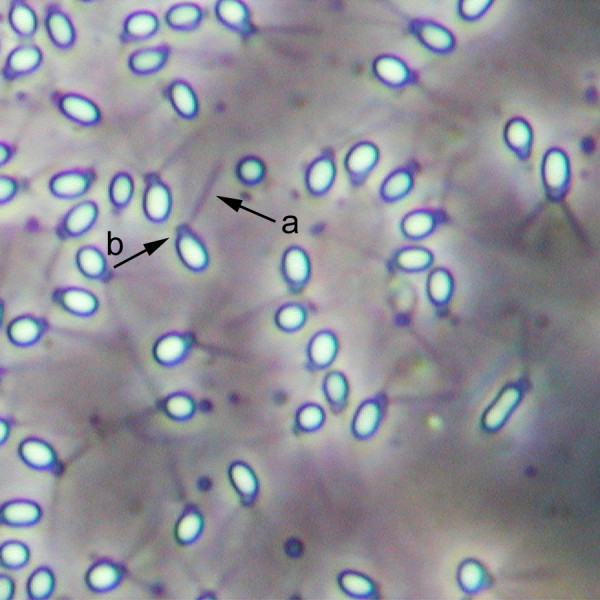
Phase contrast micrograph showing spiked appendages emanating from the spores of Bt1-88. Long straight spikes (a) emanating from a small, spore-associated parasporal body (b).